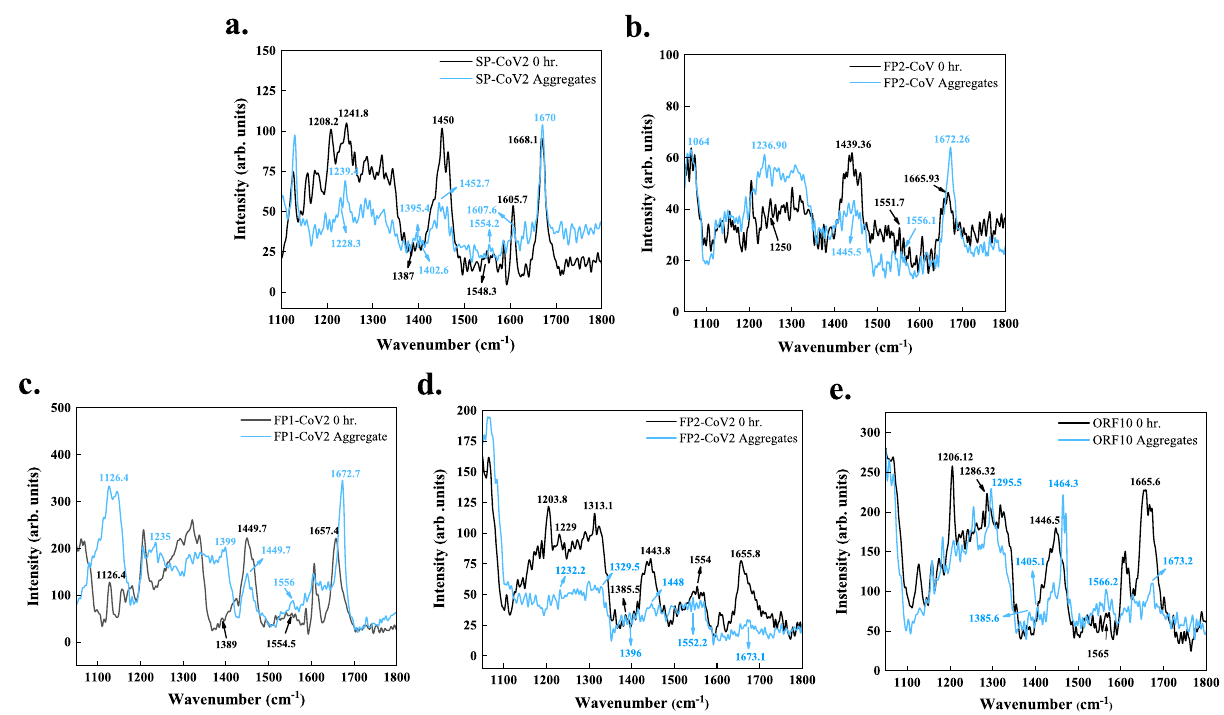
Fig.8|AmyloidformationofSARS-CoVandSARS-CoV-2peptidesprobedusing Ramanspectroscopy. Ramanspectrawereacquired onexcitationat633nm from wavenumber 1050cm − 1 to 2000cm − 1 for monomers and aggregates of a SP-CoV2, b FP2-CoV, c FP1-CoV2, d FP2-CoV2,and e